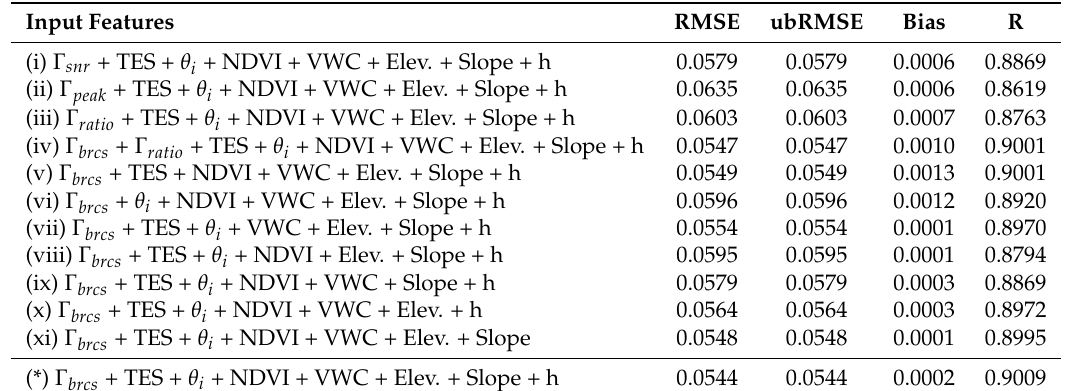
Table 4. Assessment of the input feature contributions to the learning process. The statistical performance metrics are given for the entire data set. (*) The bottom-most row shows the optimal performance, which in turn has the input features set that is used in this